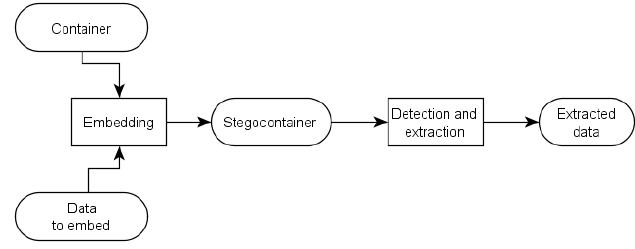
Fig. 1. A simplified steganographic process